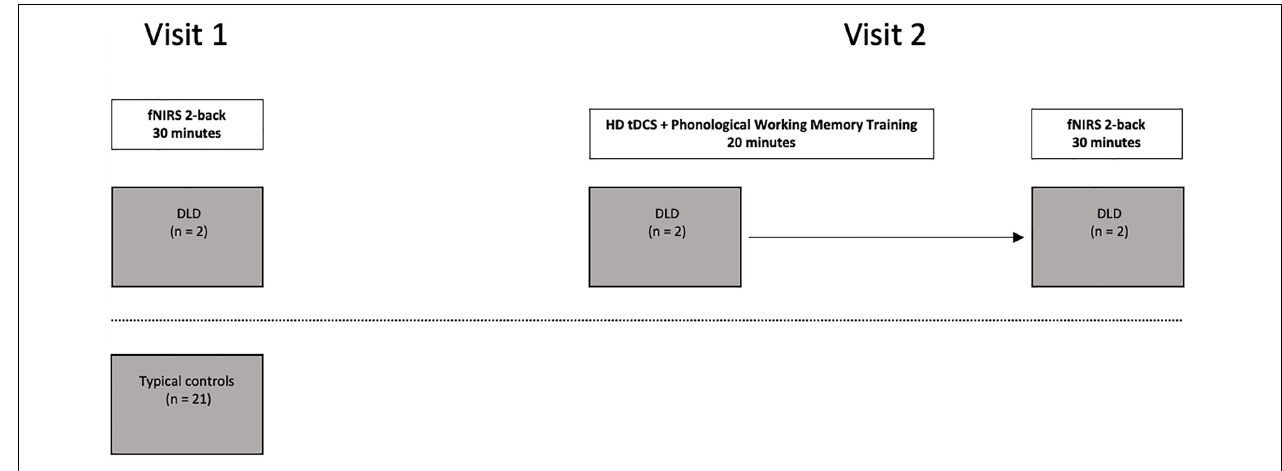
FIGURE 1 | Study design outline for the participants with DLD ( n = 2) and typical controls ( n =